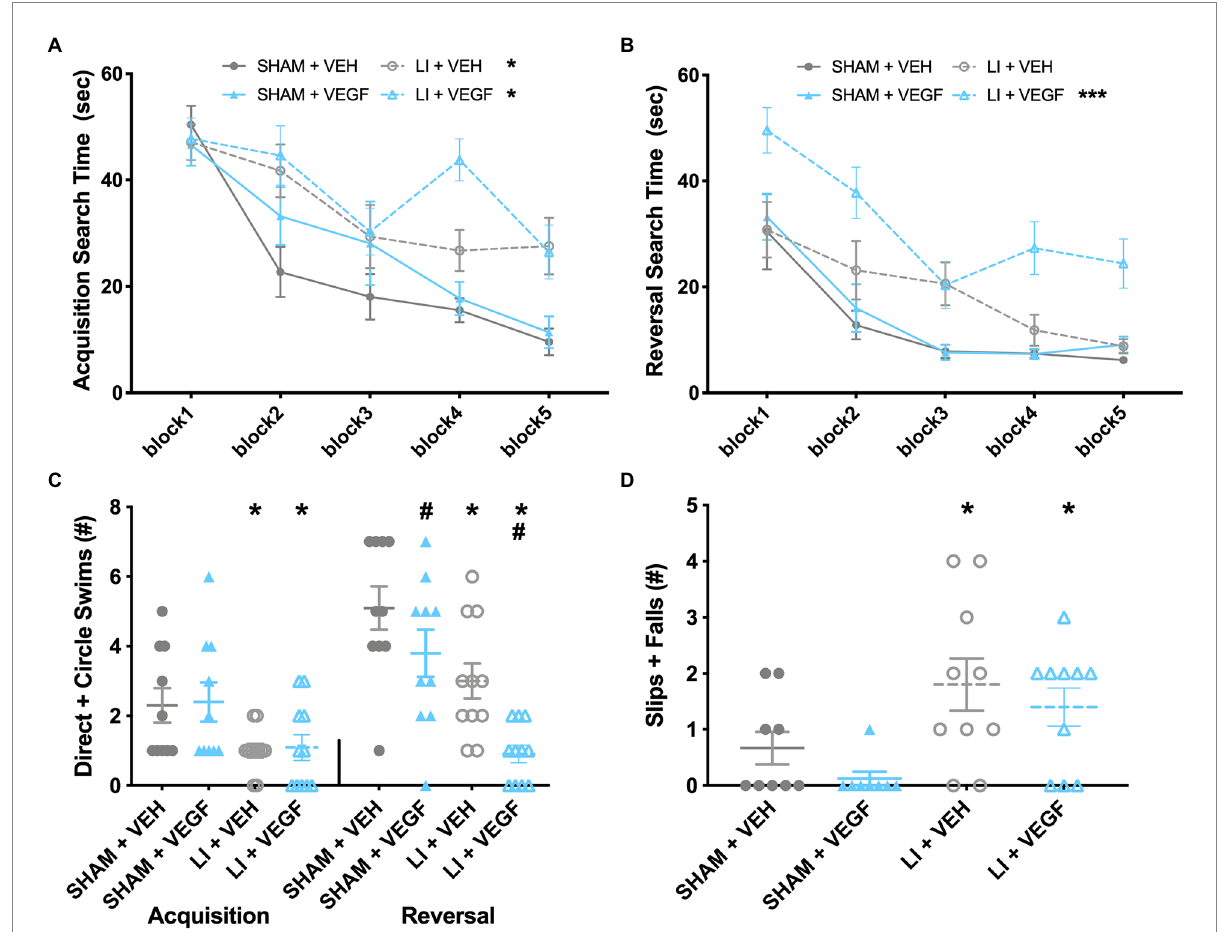
FIGURE 2 Behavior findings in male rats. (A) During water maze acquisition, male LI rats spent significantly longer than sham rats to find the platform on trials 3, 7, 8, 9, and 10. (B) During water maze reversal, LI + VEGF rats took longer to find the platform than all other groups. (C) LI rats had fewer direct and circle swims than sham rats during acquisition. During reversal, both VEGF and LI rats had fewer direct and circle swims. (D) LI rats had more slips and falls than the shams on beam task. *, LI rats significantly different than sham rats; #, VEGF treated rats significantly different than VEH treated rats; ***, different than all other groups; p < 0.05. Sham+VEH, n = 10; Sham+VEGF, n = 10; LI + VEH, n = 11; LI + VEGF, n = 11; except for beam, Sham+VEH, n = 9 Sham+VEGF, n = 8; LI + VEH, n = 10; LI + VEGF, n = 10. Error bar = SEM; water maze block = mean of every two